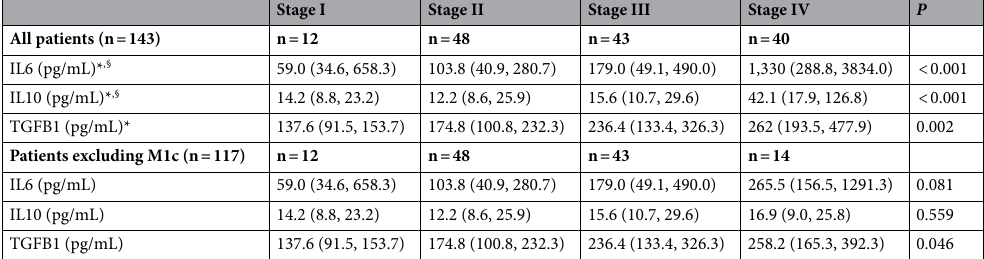
Table 2. Cytokine levels ¶ in the ascites according to TNM stage. IL interleukin, TGFB1 transforming growth factor beta1. *p < 0.017, by Kruskal–Wallis test for stage I vs. stage II vs. stage III vs. stage IV. † p < 0.0056, Bonferroni adjusted p-value by Mann–Whitney U test for stage I vs. stage II, two-tailed. ‡ p < 0.0056, Bonferroni adjusted p-value by Mann–Whitney U test for stage II vs. stage III, two-tailed. § p < 0.0056, Bonferroni adjusted p-value by Mann–Whitney U test for stage III vs. stage IV, two-tailed. ¶ Median value (first quartile, third